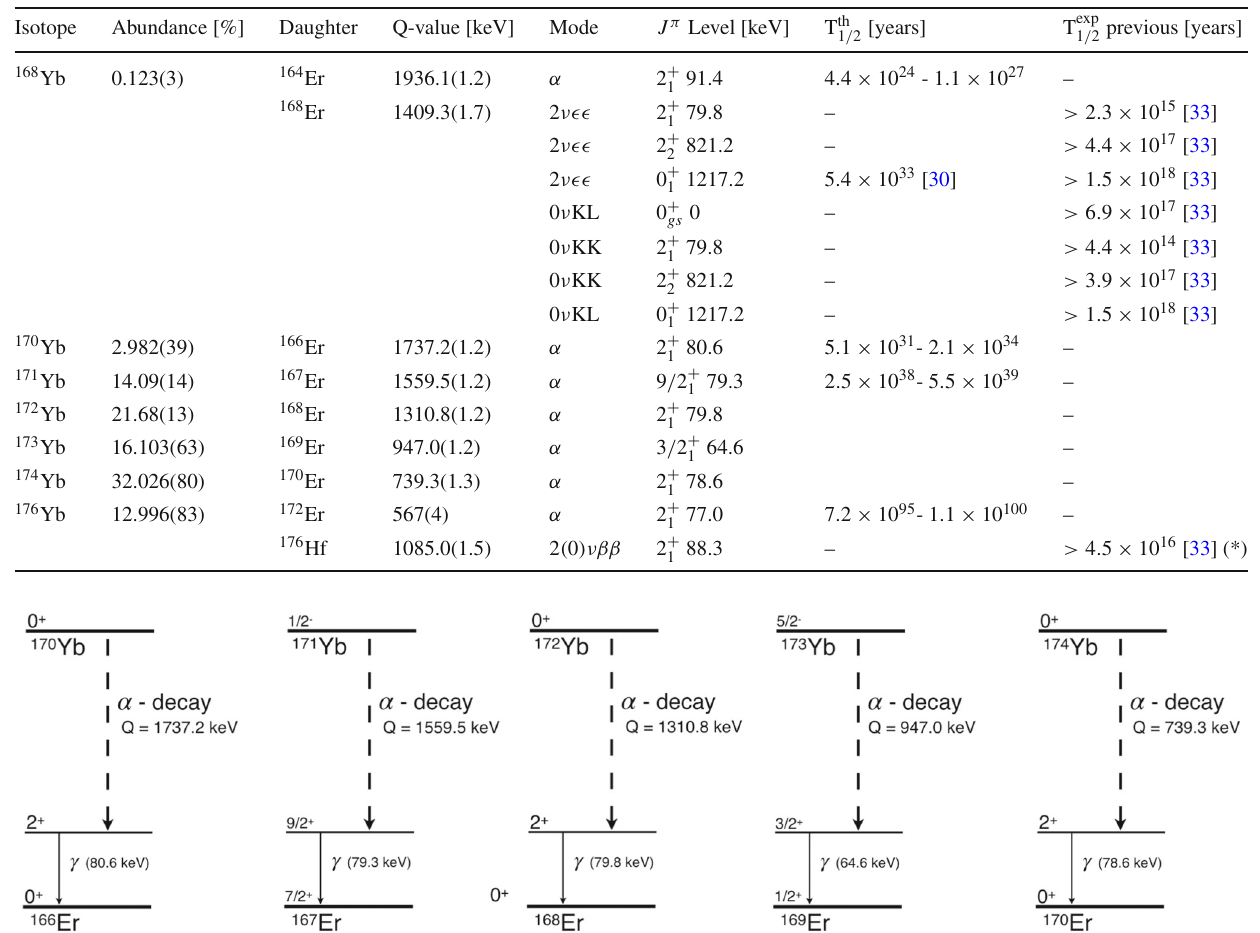
Table 1 Isotopes and decay modes investigated in this work. Shown is the Yb isotope, the natural isotopic abundance, the daughter isotope, the decay mode, the level state and energy, the Q-value, the theoretical half-life as discussed in the text and previous experimental constraints.